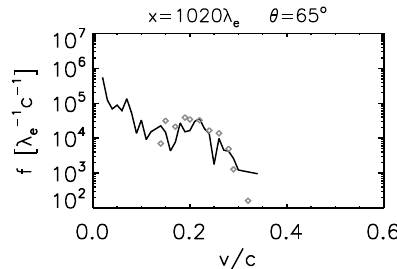
Figure 2. Cross-shock potential obtained by the three different methods: electric field integration in the global de Hoffmann Teller frame (solid curve in black in the lower panel); electric field integra- tion in the adaptive de Hoffmann Teller frame (solid curve in black in the upper panel); and electrostatic potential obtained by Liouville mapping (in gray).